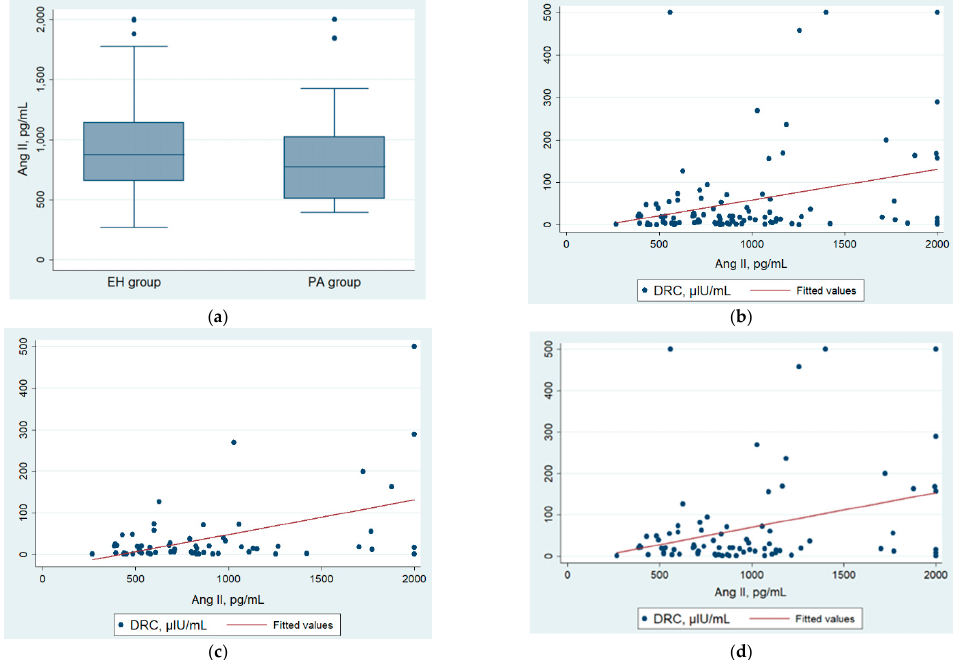
Figure 2. ( a ) Angiotensin II levels were not statistically different between PA (n = 20) and EH groups (n = 80) (773.5 vs. 873.2 pg/mL, p = 0.23); ( b – d ) the correlation between Ang II and DRC: ( b ) in the whole study population, with Spearman’s rho = 0.20 ( p = 0.04), ( c ) in the patients receiving other drugs than ACEI (64 participants) with Spearman’s rho = 0.23 ( p = 0.07), and ( d ) in the EH group (non-PA, 80 patients), with Spearman’s rho = 0.18 ( p = 0.12). Table 4. Hormonal results—comparison between PA and EH groups.